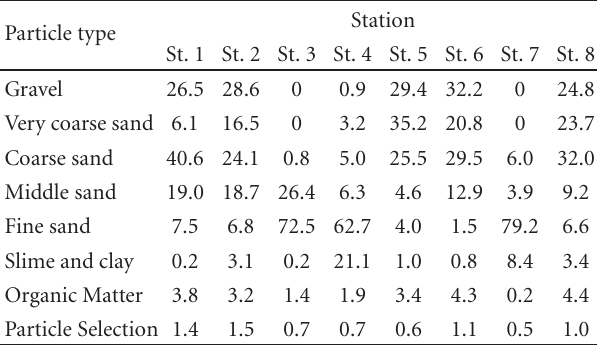
Table 3: Particle size distribution (%), organic matter (%), and particle selection factor of sediments of the stationsof Bahia Malaga